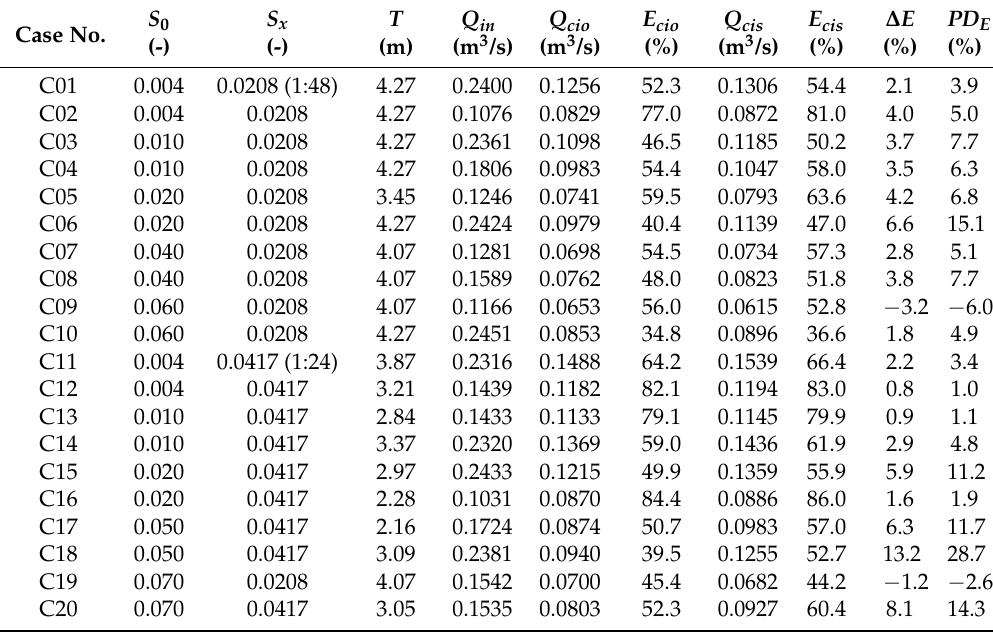
Table 3. Curb inlet test cases’ setting parameters and simulation